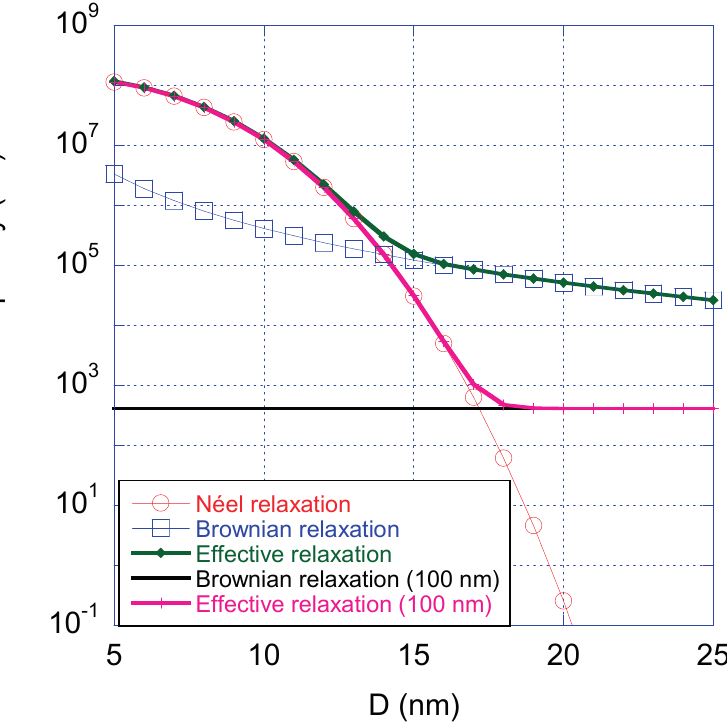
Figure 4. Magnetic relaxation time vs. the nanocrystal size ( D is the diameter of the nanocrystals) for an iron oxide based nano-sized particle system dispersed in water at room temperature, showing the Néel relaxation frequency (red), Brownian relaxation frequency (blue) and the effective relaxation frequency (green). The figure also shows the Brownian relaxation frequency of a particle with diameter 100 nm (black) and the effective relaxation (magenta) a nanocrystal will undergo positioned in that particle matrix. The parameters of nano-sized iron oxide nanocrystals used in this figure were K = 20 kJ/m 3 , τ 0 = 10 − 9 s, η = 10 − 3 Pa·s and zero shell thickness of the